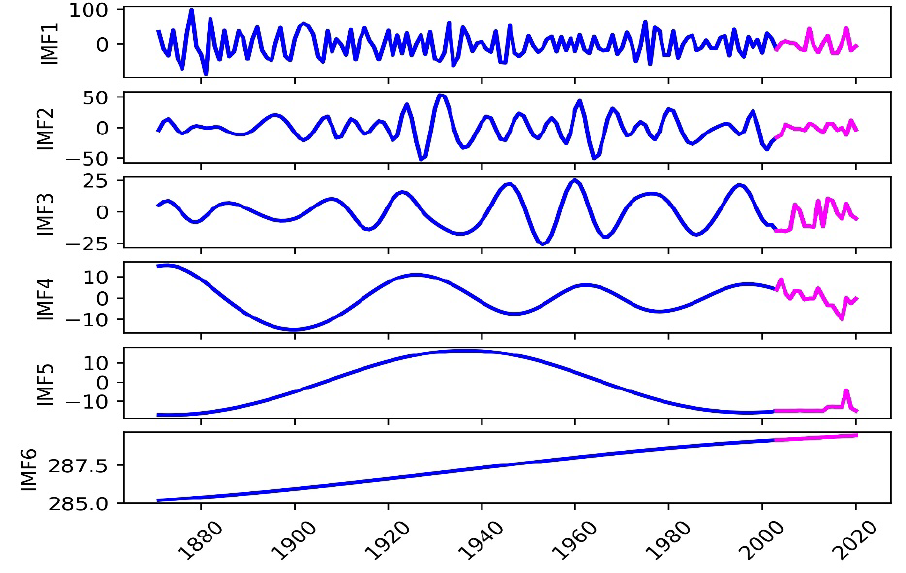
Figure 7. Plot of six IMFs from 1871 to 2020 .